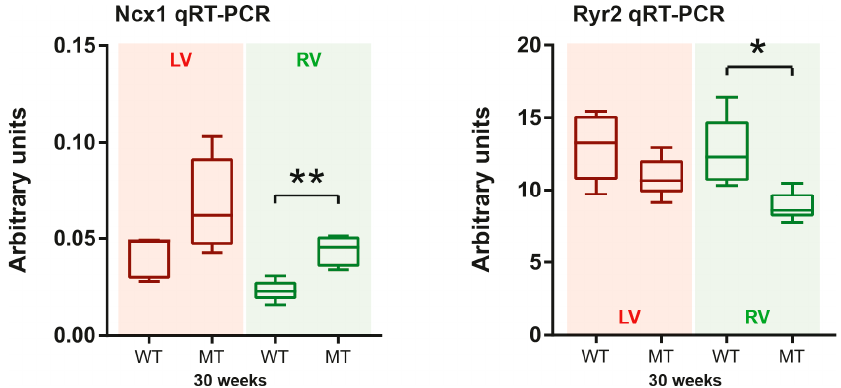
Figure 8. Ncx1 and Ryr2 mRNA expression is predominantly impaired in right ventricles during chronic AC progression. Tukey’s whisker plots depict the mRNA expression in right and left ventricles (RV and LV, respectively) of Dsg2 MT (MT) and wild-type mice (WT) as determined by qRT-PCR. The non-parametric Mann-Whitney test was applied (* p ≤ 0.05; ** p ≤ 0.01). The mRNA expression of all other assessed time points and detailed statistical analyses are available in Supplemental Tables S1 and S2.